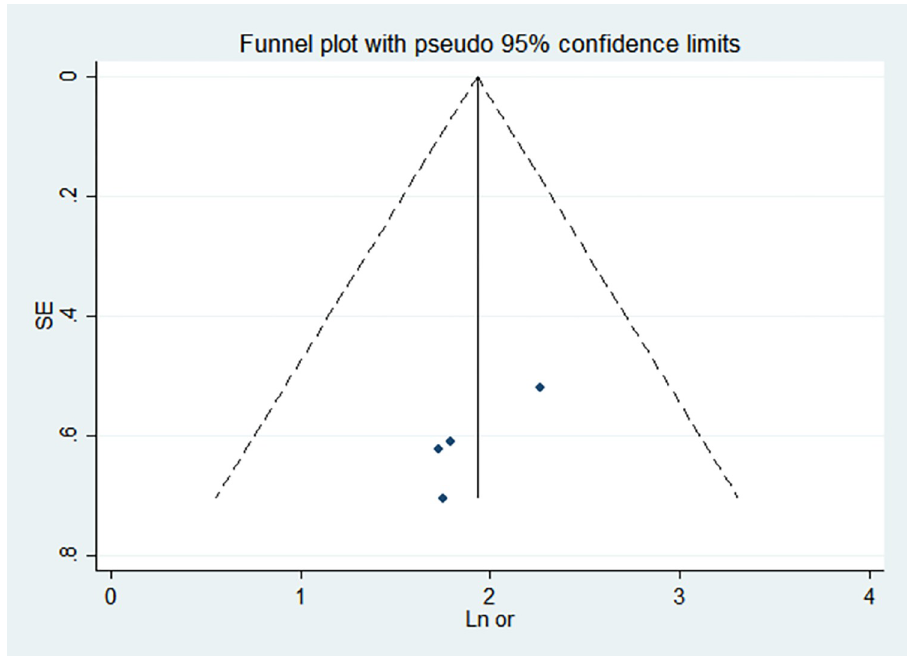
Fig 17. Funnel chart of intrauterine growth retardation.